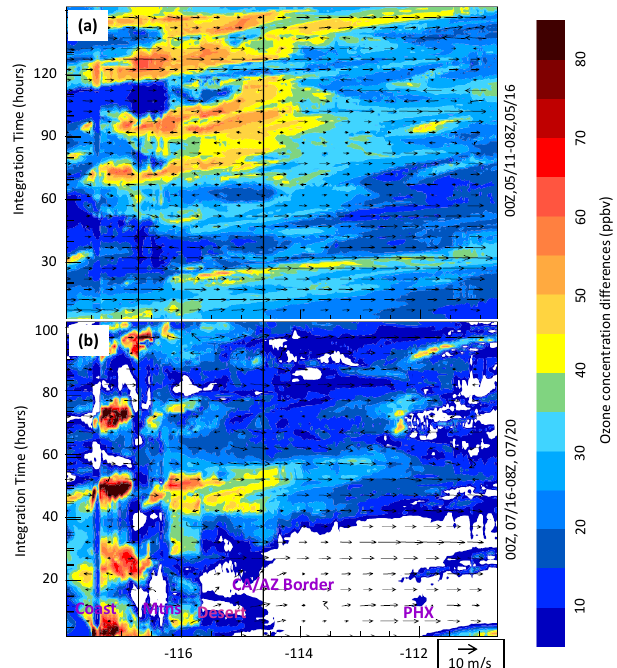
Figure 8. Hovmoller diagram of [O 3 ] differences (CTRL minus noCA) at 13th vertical model layer (about 1100ma.g.l.) along the cross-section B’B shown in Fig. 1b for May case (a) and July case (b) . Approximate locations of Phoenix (PHX), desert, mountains (Mnts), and coast are also labeled in (b) . The integrating is counted from 00:00UTC, 10 May 2012, and 00:00UTC, 15 July 2005, re-